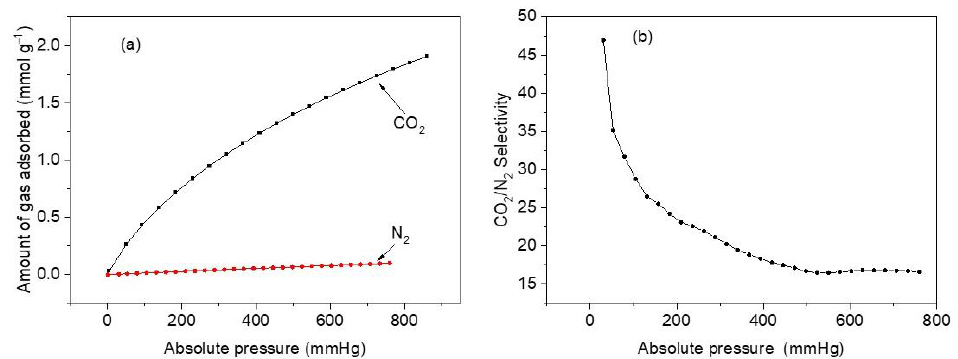
Figure 11. ( a ) CO 2 and N 2 adsorption isotherms at 25 °C and pressure between 1 and 760 mmHg for sample M11 of CoHCFs; ( b ) adsorption selectivity curve of CO 2 /N 2 at the adsorption temperature of 25 °C, pressure range of 1 – 760 mmHg, and CO 2 :N 2 = 15:85 for sample M11 of CoHCFs.